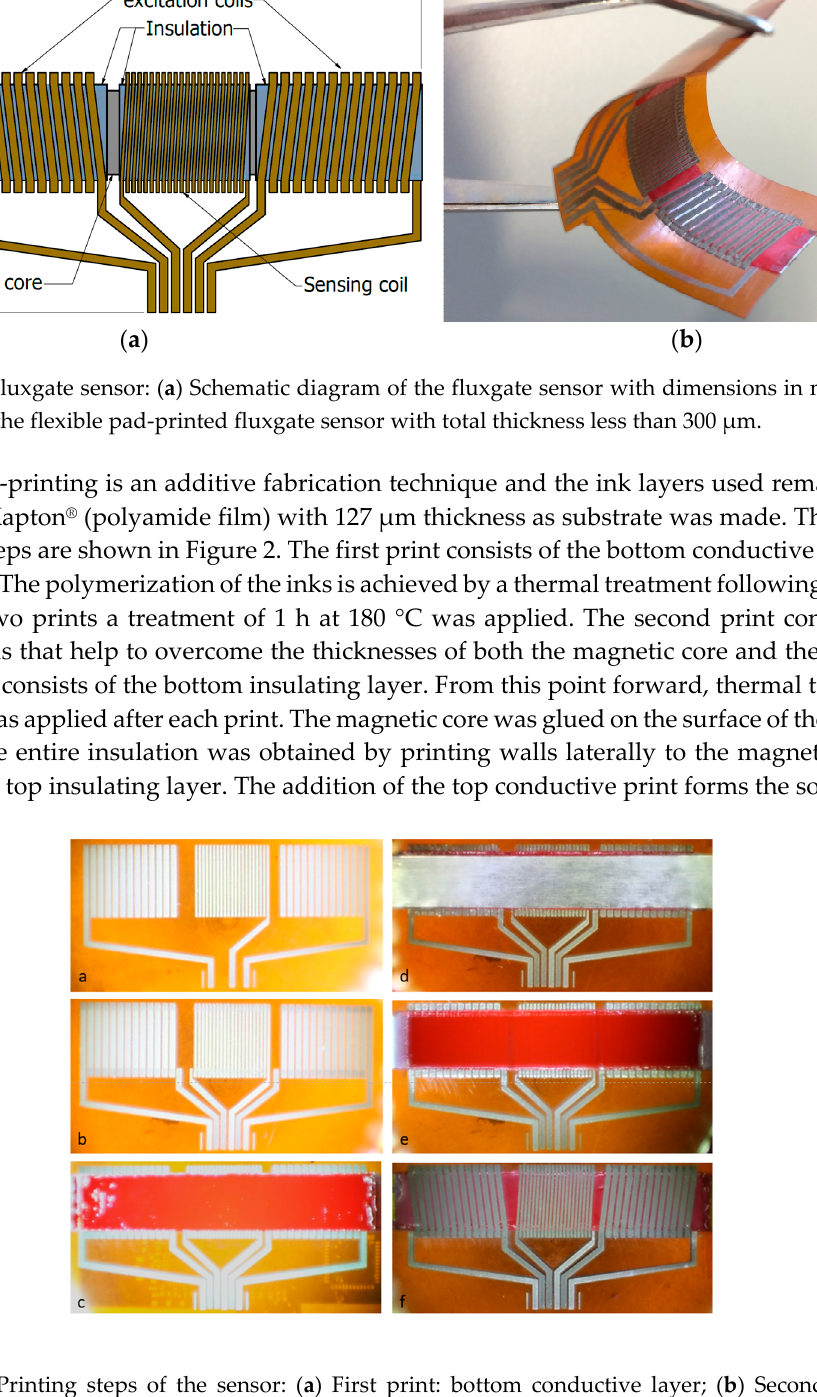
Figure 2. Printing steps of the sensor: ( a ) First print: bottom conductive layer; ( b ) Second print: Conductive vias; ( c ) Third print: bottom insulating layer; ( d ) Mounting and attachment of magnetic core; ( e ) Fourth print: top insulating layer; ( f ) Fifth print: top conductive